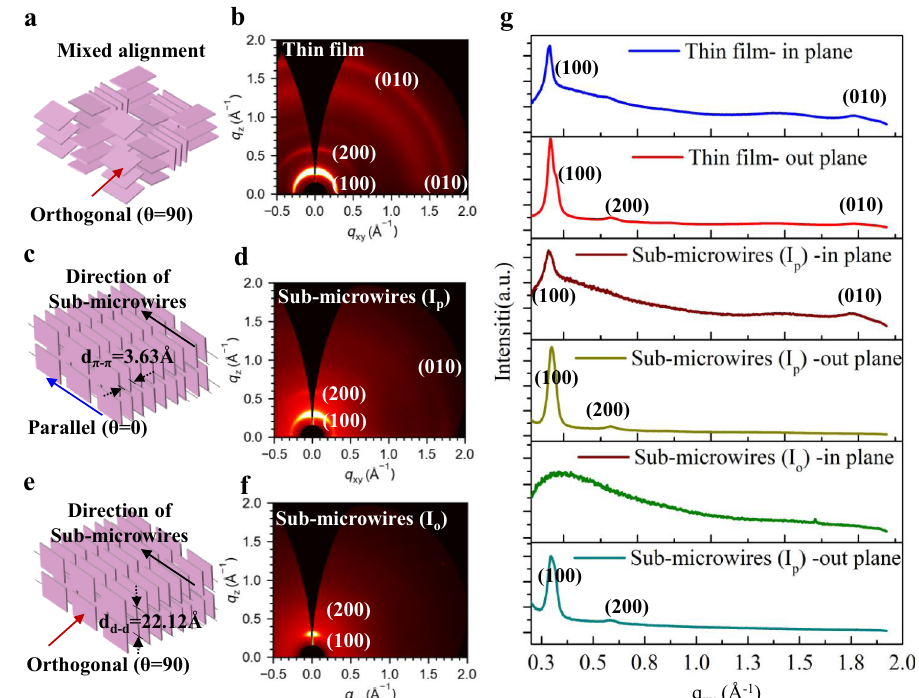
Fig. 4 | GIWAXSanalysis ofPDVT-10 sub-microwires and thin fi lm. a Schematic of the mixed alignment in PDVT-10 fi lms. b 2D-GIWAXS analysis of thin fi lm. c Schematic of π – π stacking in sub-microwires, the blue arrows show the direction of the incident beam parallel to the long axis of the sub-microwires. d 2D-GIWAXS analysis of sub-microwires (incident beam parallel to the length